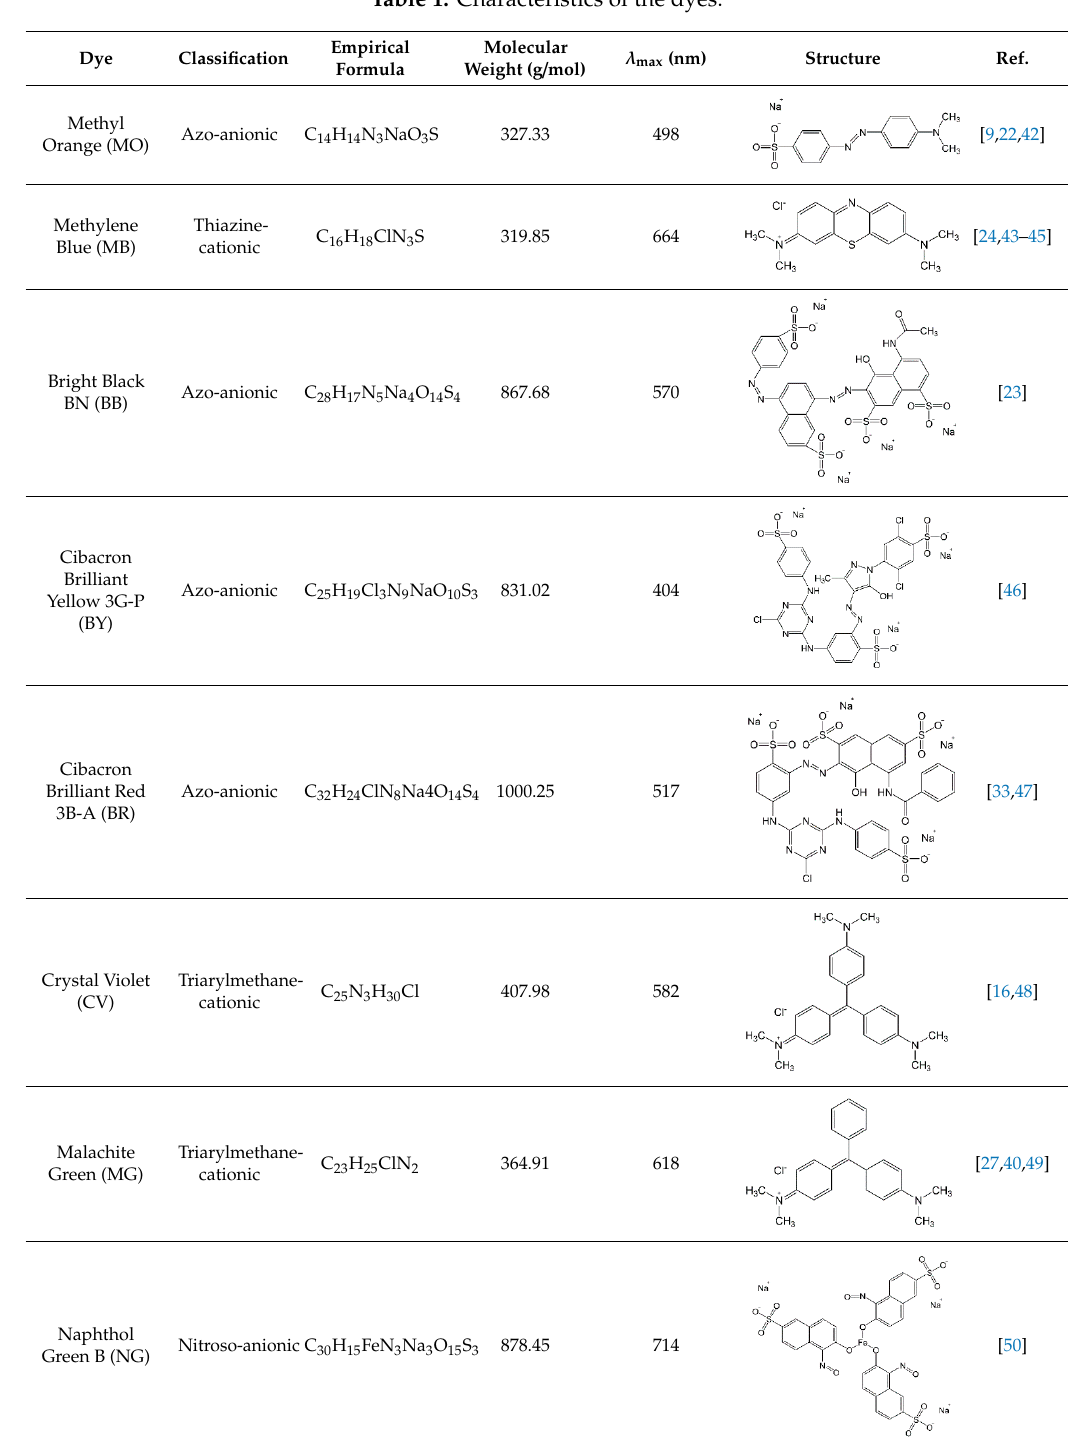
Table 1. Characteristics of the dyes.